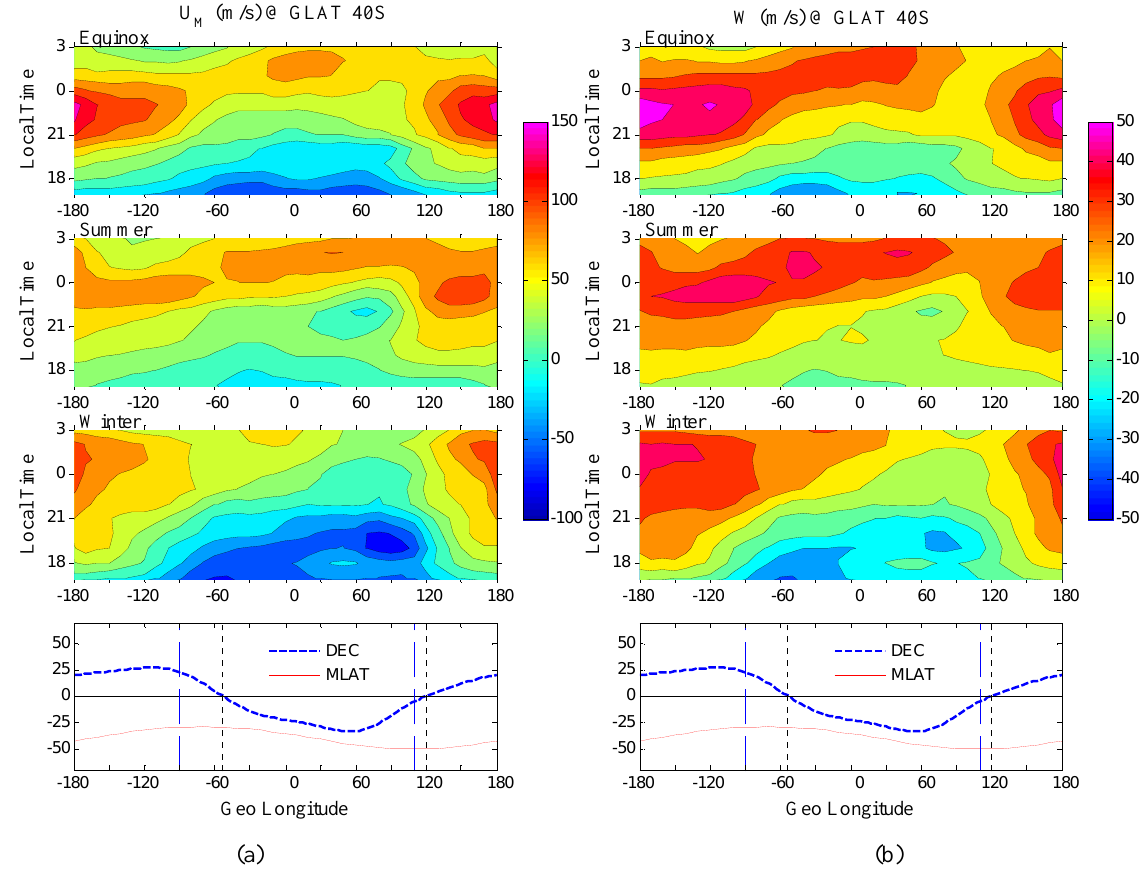
Figure 3. The derived magnetic meridional winds (U M , left) and the wind-induced vertical plasma drifts ( W , right) for local equinox, summer and winter at 40 ◦ S. The magnetic declination angle is also shown. In the bottom panels, blue dashed lines represent the edges of the longitudes where the WSA occurs. The meridional winds are equatorward positive and the vertical drifts are upward positive. Figures 1 and 2 show that larger absolute and relative elec- background electron density in the evening and the lack of the ionization source in the negative DEC region after mid-